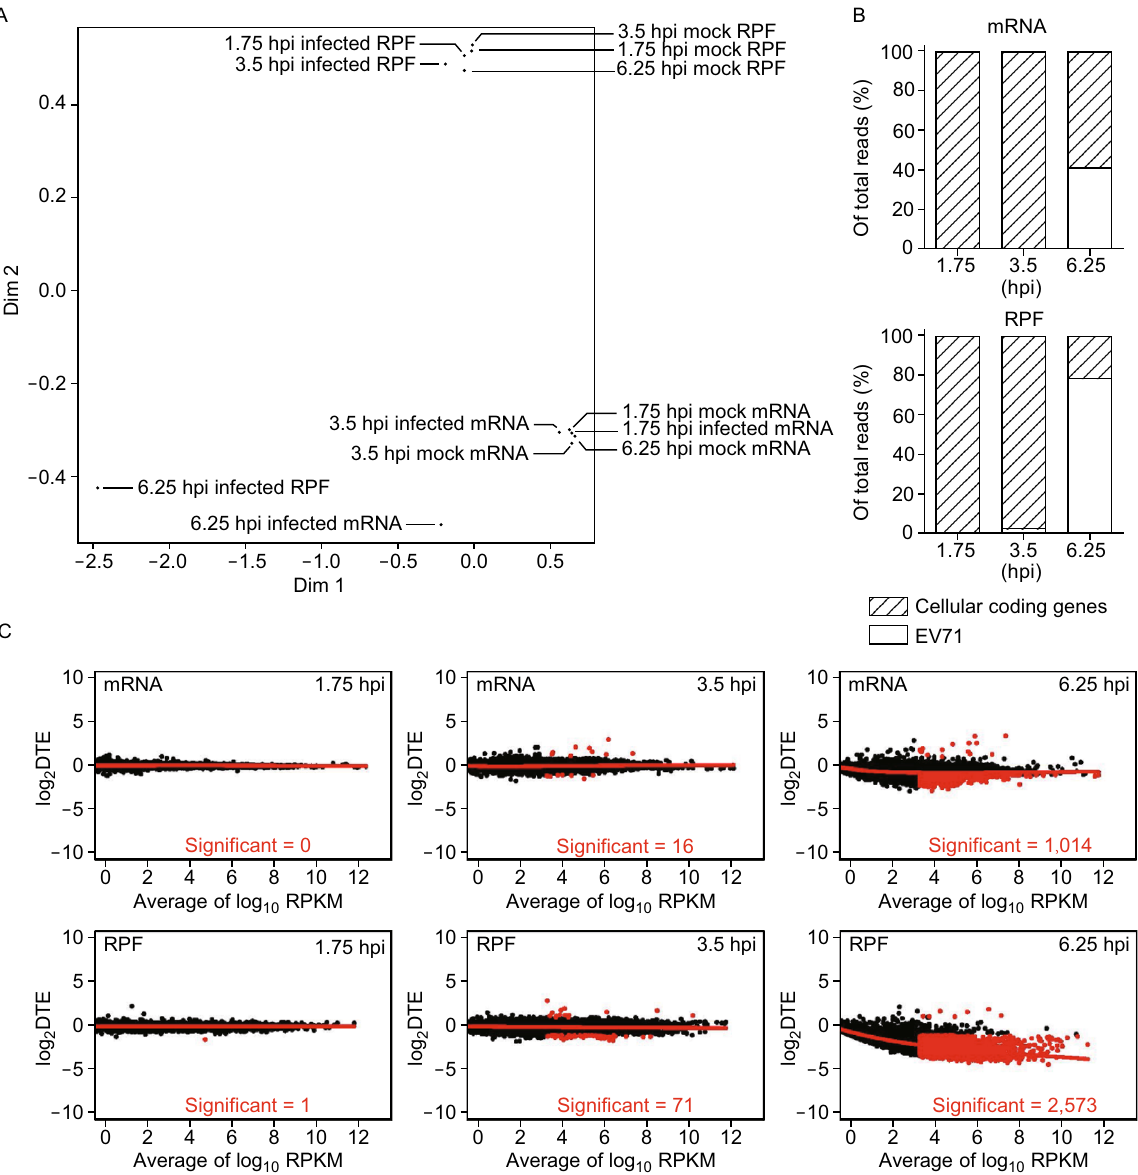
Figure 1. Reduced translation of cellular mRNAs plays a key role in EV71-induced host shutoff . (A) Principal coordinates analysis (PCoA) of gene expression shows transcriptional and translational levels of cellular gene expression (Set 1). Each point represents the indicated data point. (B) Proportion of reads mapped to EV71 RNA and cellular protein coding regions at different times after EV71 infection (Set 1). (C) Scatter plot of mean logarithmic value under mock- and EV71-infected conditions of mRNA/ RPF reads versus logarithmic value of difference of mRNA/RPF (DTE) (Set 1). Genes that changed signi fi cantly (fold change >2) are shown in red. Number of up/down regulated genes are also